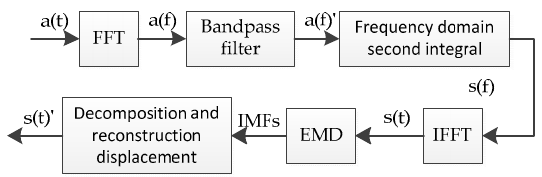
Figure 6. Flow field based on FFT+EMD adaptive filtering process.